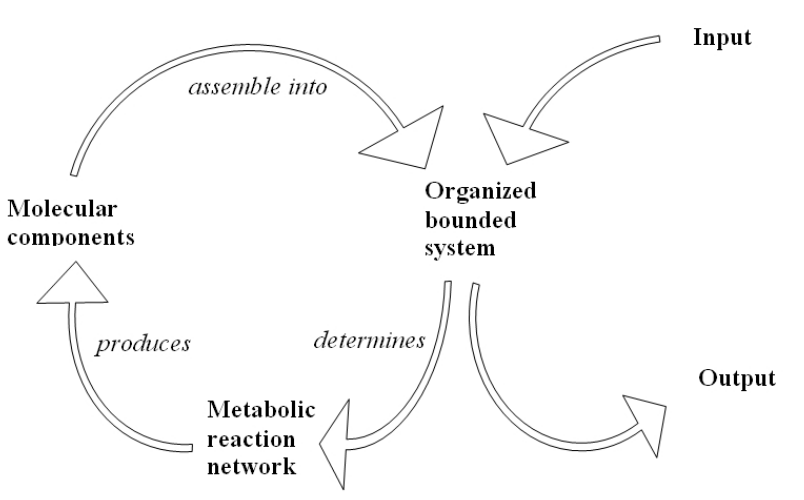
Figure 5. The cyclic process of metabolic biochemical